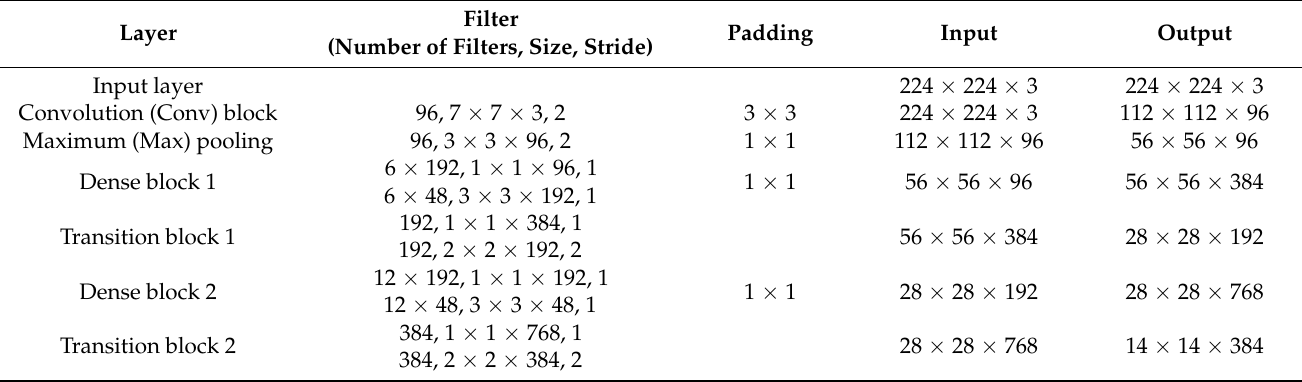
Table A1. Structure of original